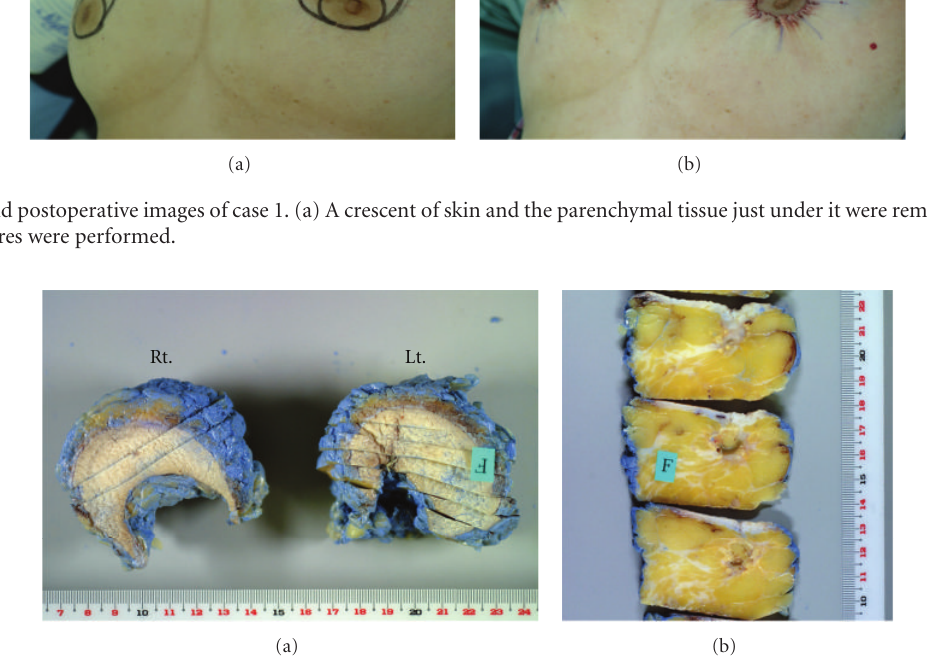
Figure 4: Bilateral resected tissue. (a) The resected tissues weighed 94g (right) and 104 g (left), respectively. (b) Fixed and sliced tissue used for the histological examination. No residual cancer cells were seen in the left